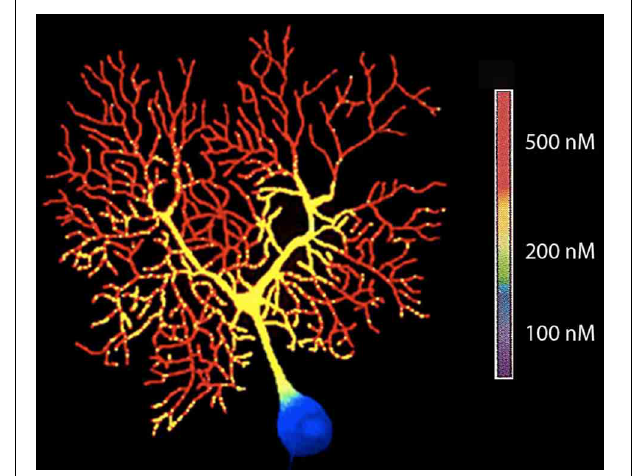
FIGURE 3 | High-resolution fluorescent image of a dendritic calcium spike in a Purkinje cell filled with fura-2 by microinjection (380-nm excitation). (From Tank et al.,